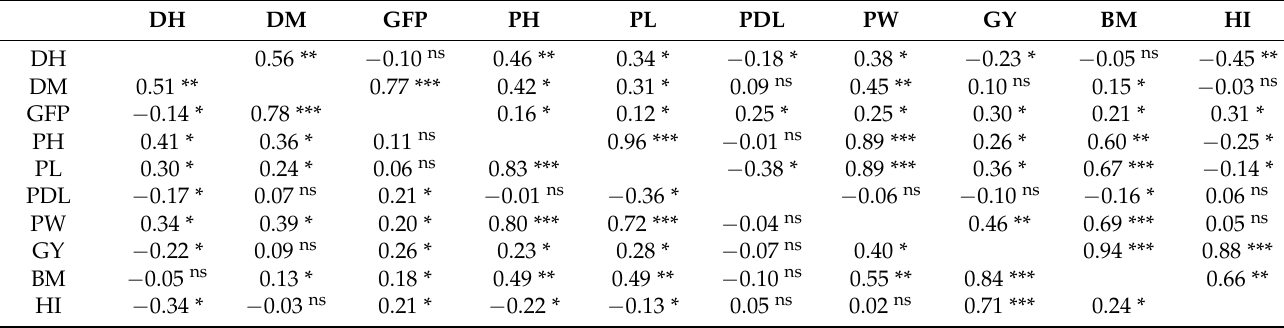
Table 6. Genotypic (above diagonal) and phenotypic (below diagonal) correlation coefficients between the important traits of 320 teff genotypes under the field growing